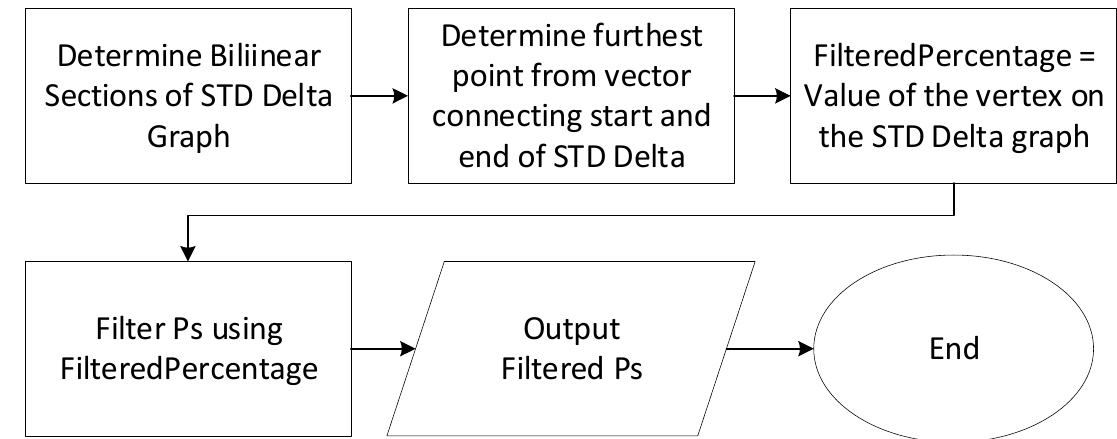
Figure 5. Final noise reduction pass to determine the accurate data.